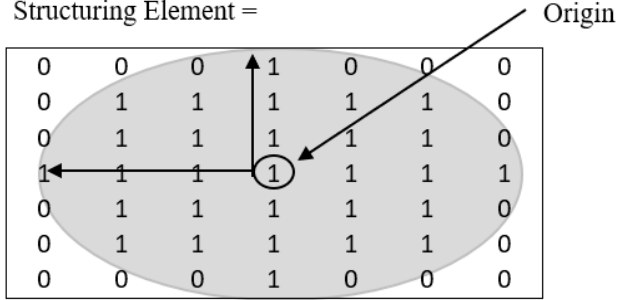
Figure 4. The flat disk-shaped structuring element used in this work.